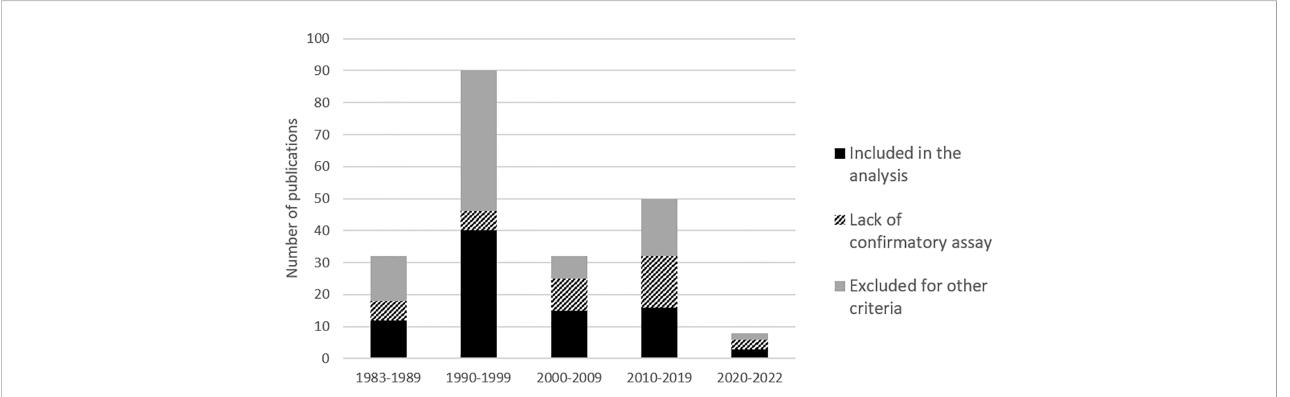
FIGURE 1 Histogram of number of publications per decades on ‘ HTLV-1 prevalences ’ in Africa, from 1983 to July 2022. The shades of gray to black represents the percentage of studies lacking con fi rmatory results and of studies excluded for other criteria that are detailed in fi gure 2 (mainly other type of population, low numbers and disease report studies).